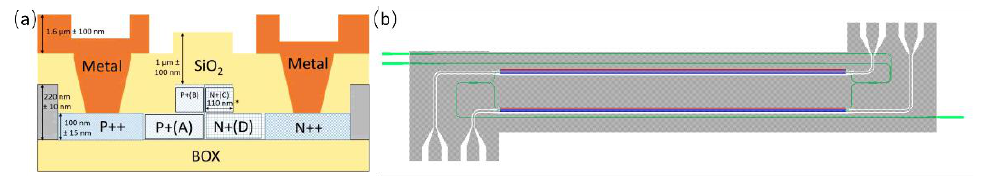
Figure 5. A typical Si Mach-Zehnder interferometer (MZI) depletion modulator ( a ) cross-section schematic and ( b ) GDS-II layout.